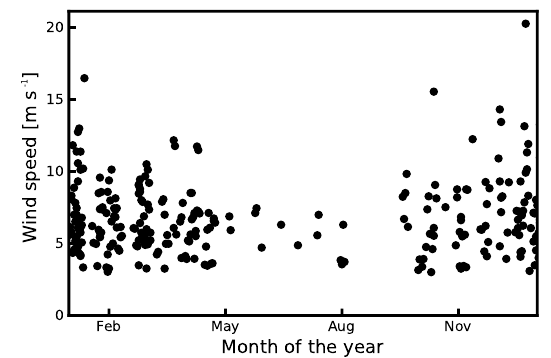
Figure 5. Days of “potentially upwelling-favourable” winds north of Svalbard 1987–2017, assuming that the local bathymetry facili- tates such upwelling, based on ERA-Interim data (Dee et al., 2011) for the region 79–81 ◦ N, 5–30 ◦ E. A daily wind speed was consid- ered “potentially upwelling-favourable” if its (approximately east- erly) along-shelf component exceeded 3ms − 1 for at least 3 con- secutive days. (3ms − 1 is a rather low wind speed, well below the “optimal environmental window” of 5–6ms − 1 for upwelling sug- gested by Cury and Roy (1989) and makes for a generous criterion in this regard. Likewise, Kämpf and Chapman (2016, Sect. 2.1) give a timescale of around 5 days from the onset until the com- plete development of coastal upwelling. Effectively, both criteria should err on the upwelling-favourable side.) From the beginning of May through August each year, ∼ 2% of all days were “poten- tially